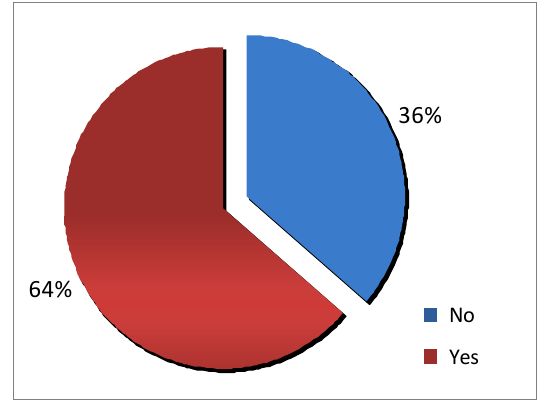
Figure7. Graph showing SC members responses to the question on whether they stayed in contact with participants and other people after the Summer School had ended The ISPRS SC member survey showed that more than 50% of Summer School participants learned about it through the SC